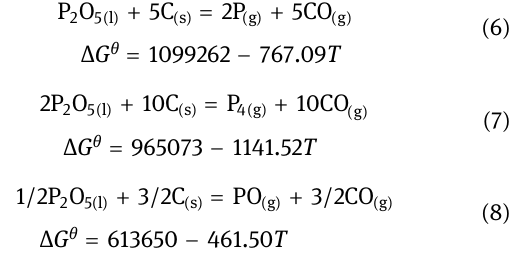
The chemical reactions of pure P